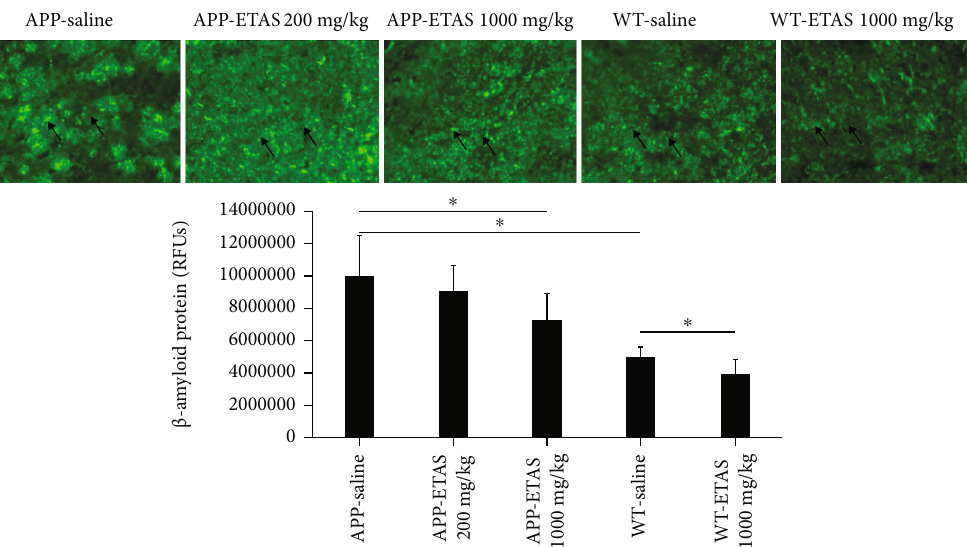
Figure 5: Quanti fi cation of β -amyloid protein in the hippocampus of APP-overexpressed mice treated with ETAS (200mg/kg and 1000mg/kg) and WT mice treated with ETAS (1000mg/kg) for 1 month, respectively. ∗ p < 0 : 05 APP-ETAS (1000mg/kg) vs. APP saline- treated mice ∗ p < 0 : 05 WT-ETAS (1000mg/kg) vs. WT saline-treated mice; RFUs: relative fl uorescence units. Four mice per group and four sections per mouse were used; green represents β -amyloid protein, and blue represents DAPI. Arrows represent fl uorescent green staining, indicating positive expression. Magni fi cation is represented × 200.